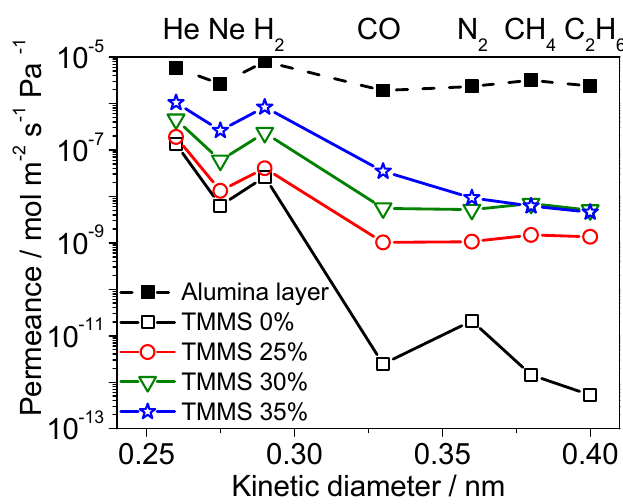
Figure 6. Gas permeation properties at 300 °C (permeance versus kinetic diameter of gas species (He, Ne, H 2 , CO 2 , N 2 , CH 4 , C 2 H 6 )).